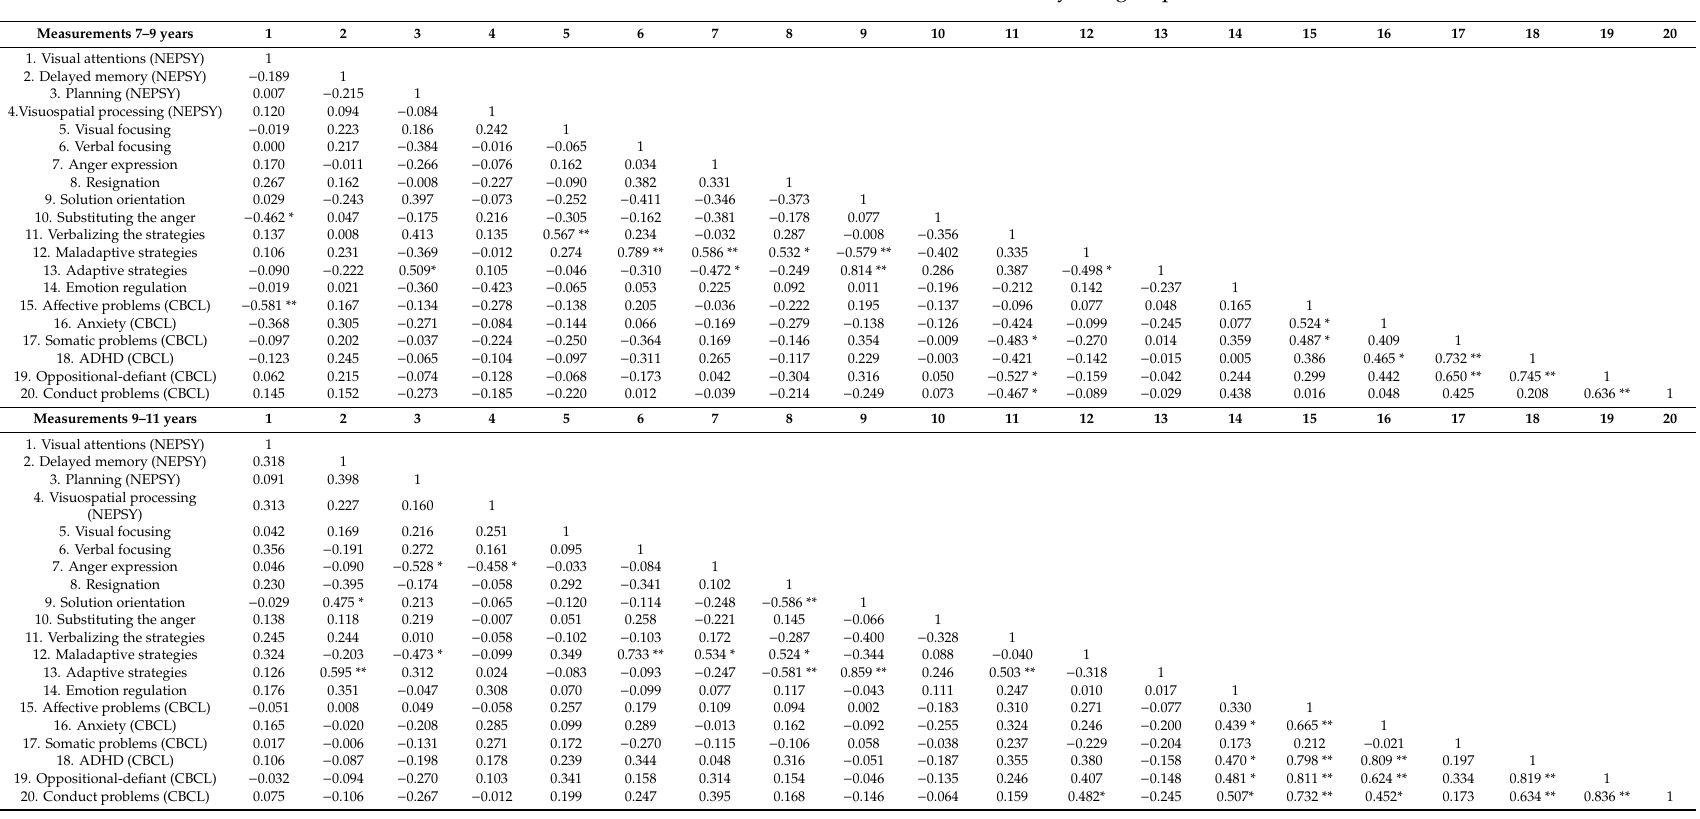
Table A2. Correlation coe ffi cients for the 7–9 and 9–11-years